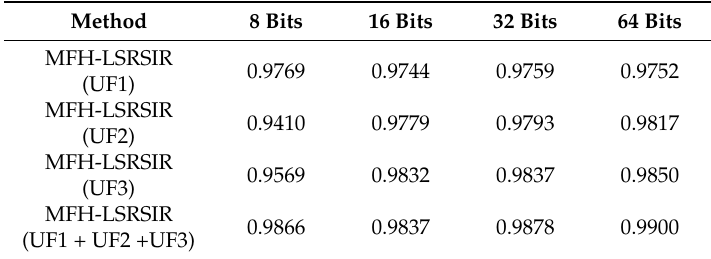
Table 3. MAP scores of the SAT-6